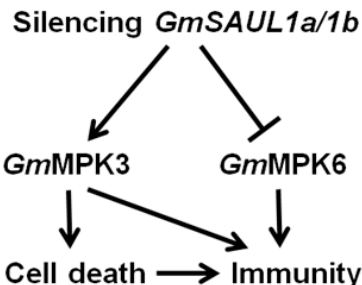
Figure 7. Silencing GmSAUL1a/1b triggers cell death through enhancing the activation of Gm MPK3. The elevated immunity in GmSAUL1a/1b- silenced plants could be the result of the cell death triggered by the activated Gm MPK3 as well as by the compensation effect of Gm MPK3 for the reduced activation of Gm MPK6.